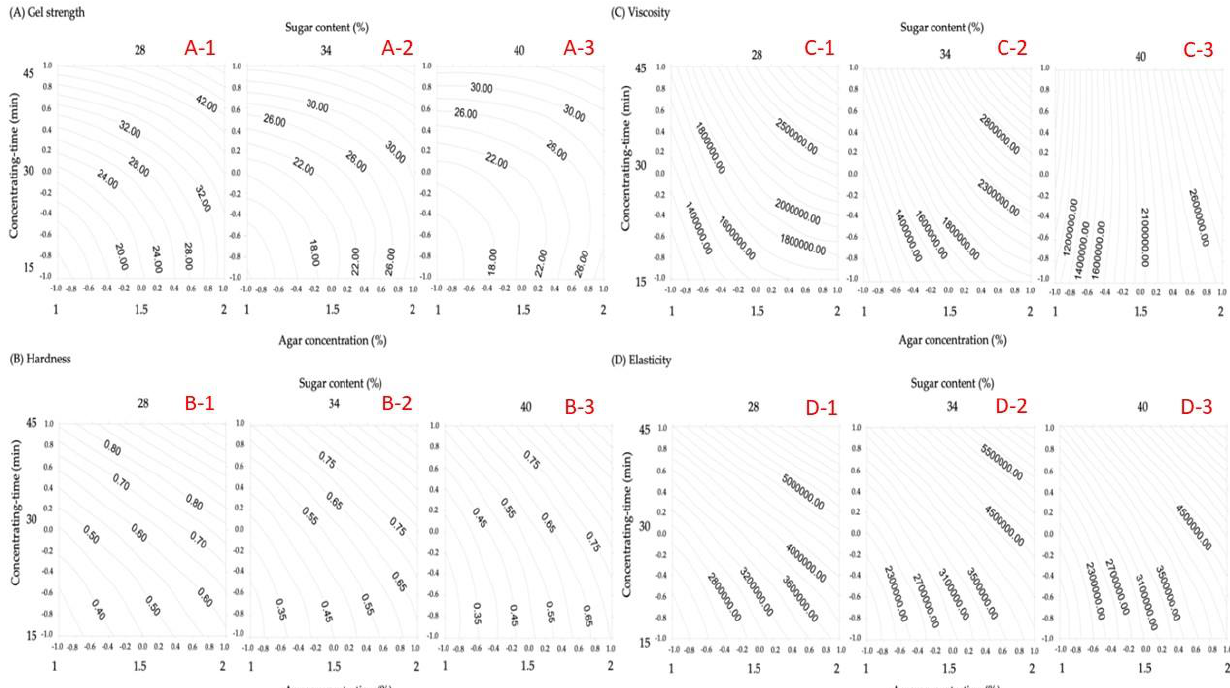
Figure 3. Contour plot of the processing conditions for the gelatinized adzuki-bean cake with respect to gel strength, hardness, viscosity, and elasticity.